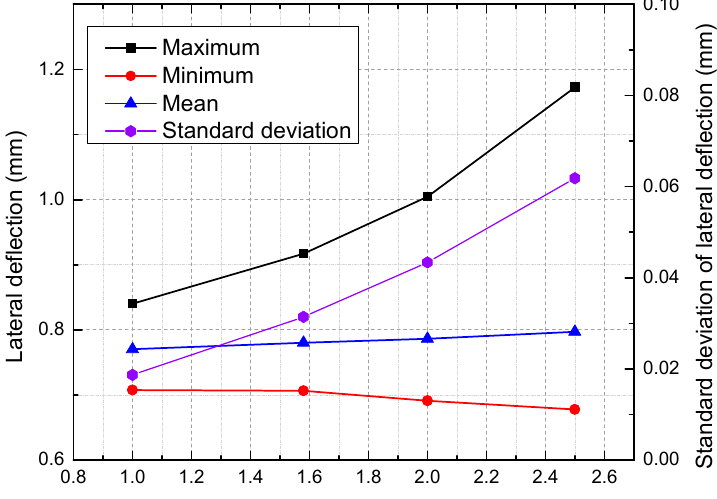
Figure 19. The maximum, minimum, mean, and standard deviations of lateral de fl ection under dif- ferent standard deviations.